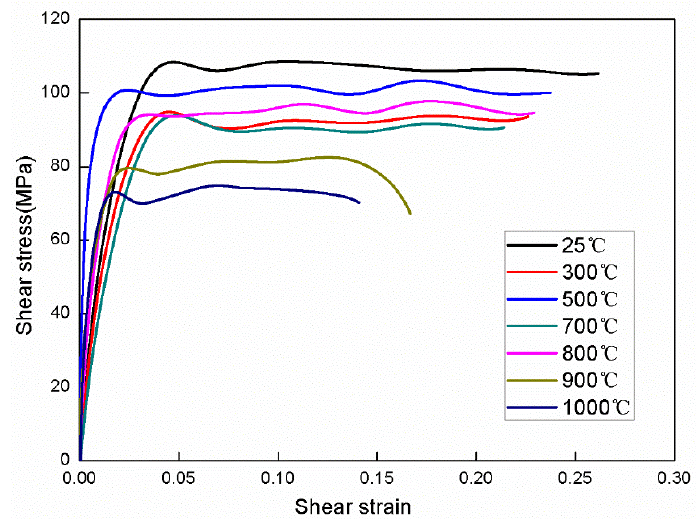
Figure 5. Shear stress-strain curve of Ti-1023 specimen at different temperatures.